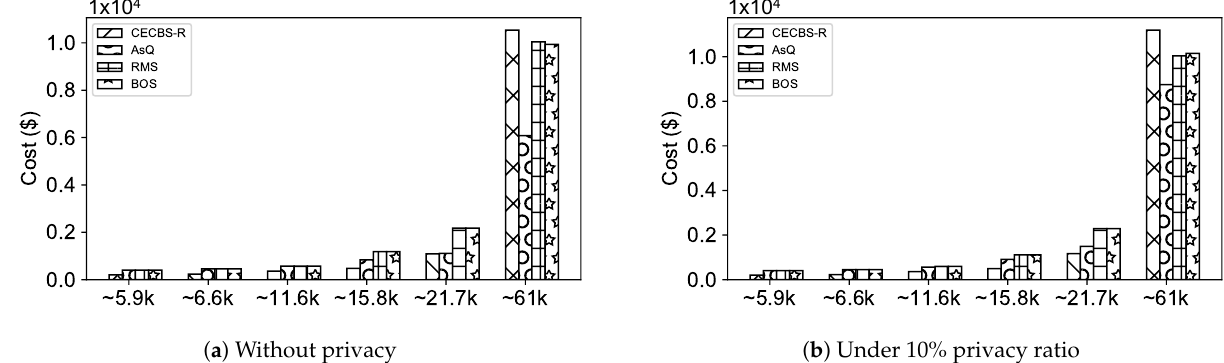
Figure 12. The total cost across the edge-cloud environment without privacy and under 10%